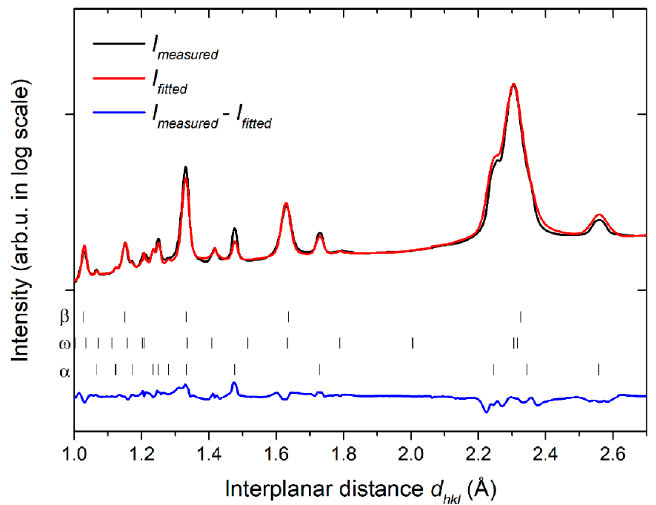
Figure 9. HEXRD pattern of the HPT-deformed sample after aging 400 °C/1 h.